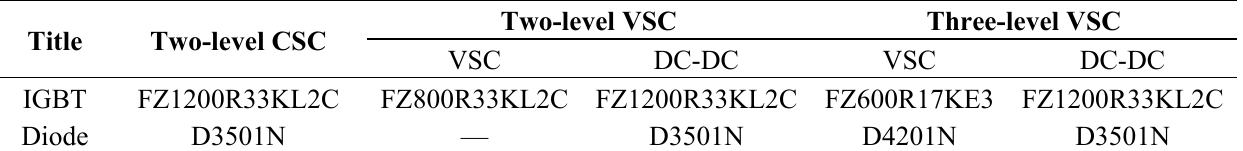
Table 4. Commercial IGBTs and diodes used in each power conditioning